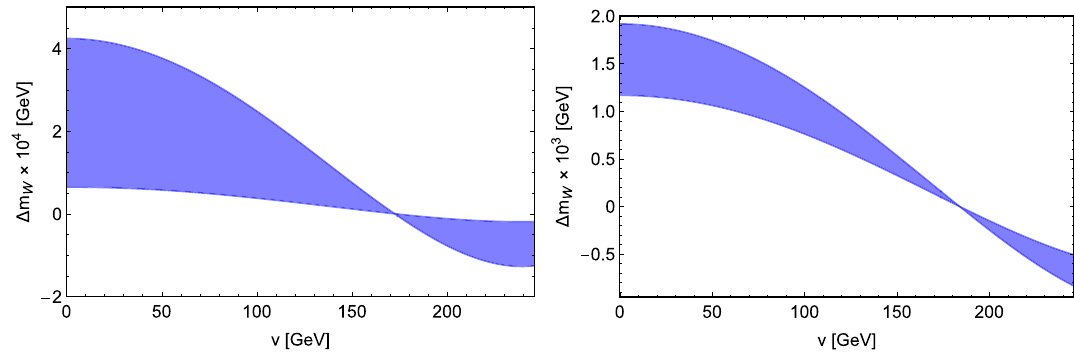
Fig. 3 Contribution of the non-degenerate gauge vector doublet to the W mass